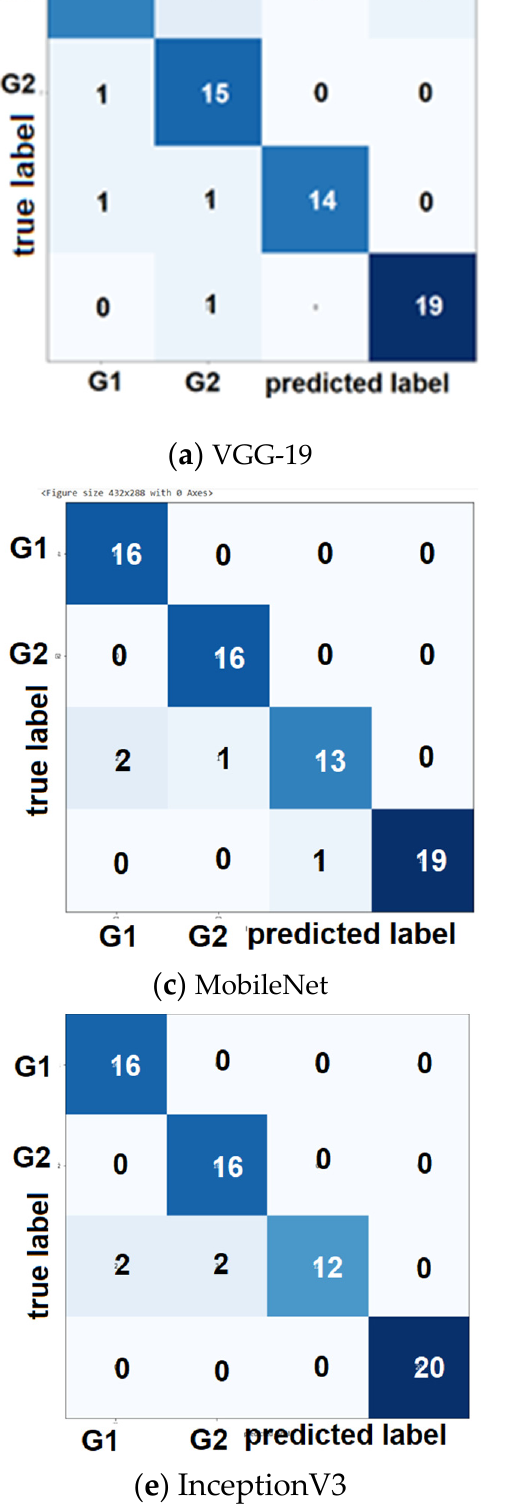
Figure 7. Confusion matrices for 4 class classification.